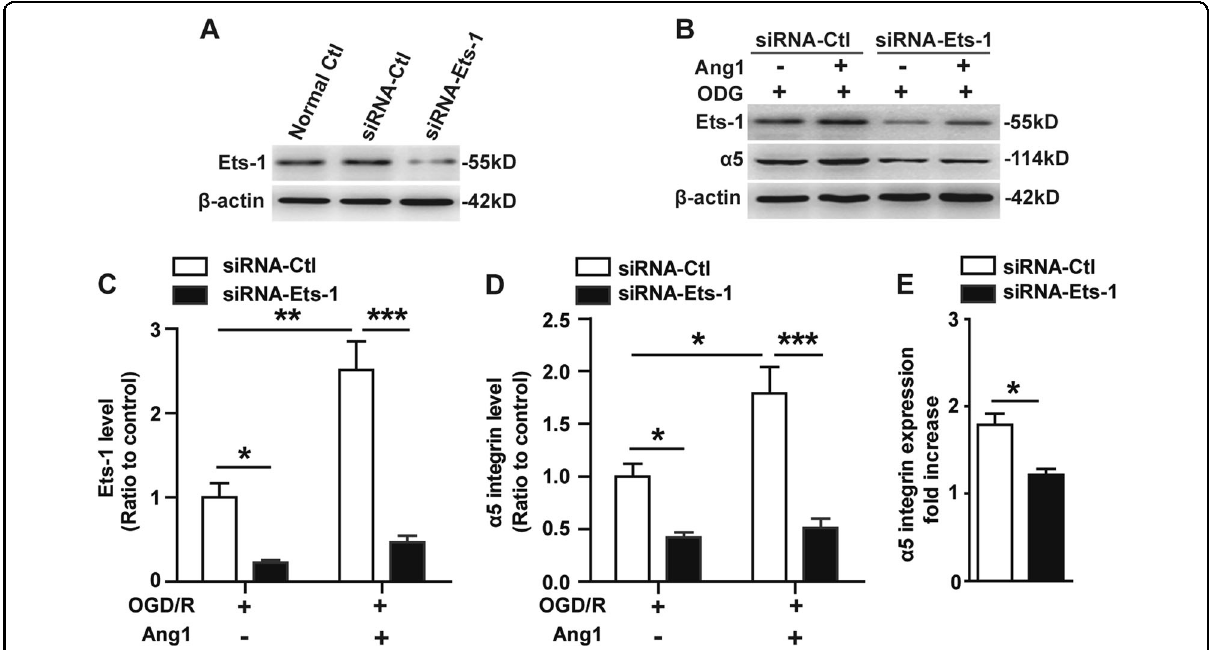
Fig. 6 Knockdown of Ets-1 reverses the upregulation of α 5 integrin induced by Ang1 after OGD. a . BECs were transfected with the negative control siRNA (siRNA-Ctl) or Ets-1-speci fi c siRNA (siRNA-Ets-1) for 48 h. Levels of Ets-1 protein were monitored in the control and silenced the cells via western blotting. b – e BECs were transfected with siRNA-Ctl or siRNA-Ets-1 for 48 h, then subjected to 4 h of OGD, and further stimulated or not with Ang1 (100 ng/mL) for 12 h under normoxia at 37 °C. b The protein levels from OGD-treated BECs lysates were analyzed by western blotting using antibodies speci fi c to integrin α 5 and Ets-1. c – e Densitometric analysis shows the relative amount of Ets-1 ( c ) and integrin α 5 ( d ) to β -actin (the OGD/ R siRNA-Ctl-treated cells served as the control) and the fold increase of integrin α 5 induced by Ang1 after OGD ( e ). Data represent the mean ± SEM and were analyzed by two-way ANOVA or Student ’ s t test (n = 3). Note that Ets-1 knockdown in BECs signi fi cantly decreased Ets-1 protein expression. Ang1 signi fi cantly upregulated integrin α 5 expression on siRNA-Ctl-treated BECs relative to the OGD/R siRNA-Ctl-treated controls, but this effect was signi fi cantly reduced by Ets-1 knockdown. * P < 0.05, ** P < 0.01, *** P <